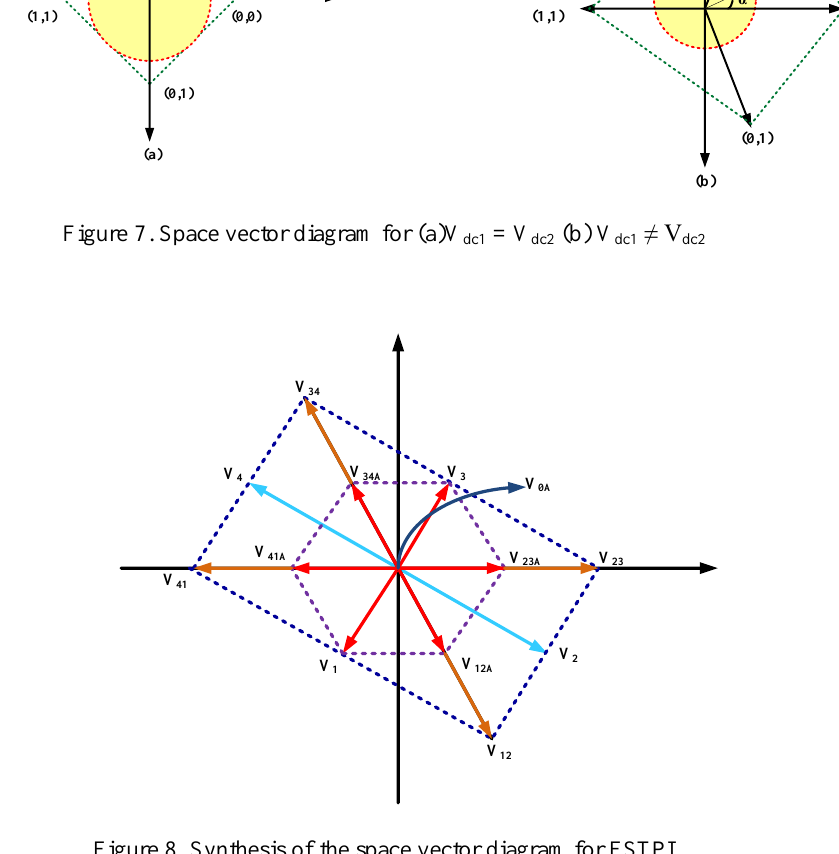
Figure 8. Synthesis of the space vector diagram for